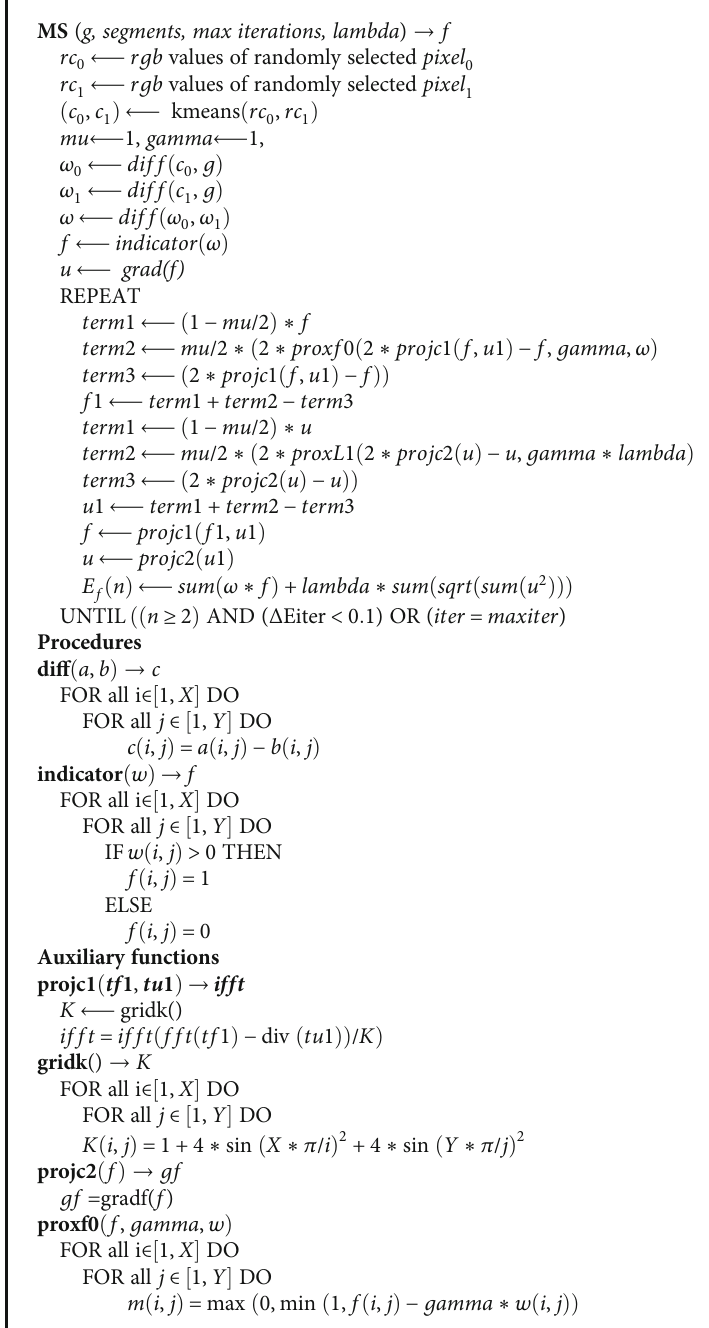
Algorithm 1: Minimization of MS model using DR